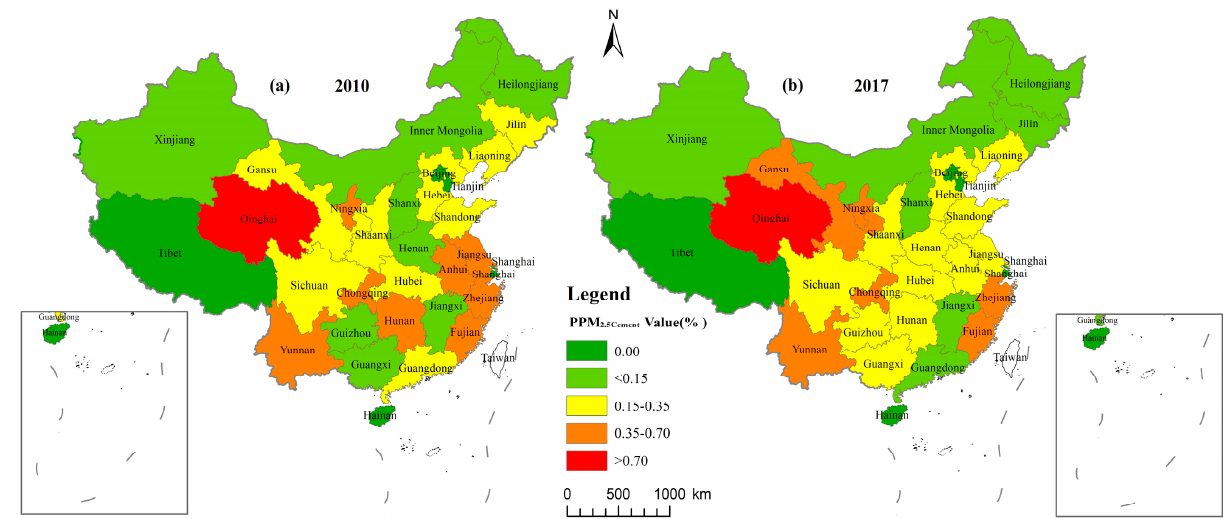
Figure 2. Spatial distribution of the PPM 2.5Cement in 2010 and 2017